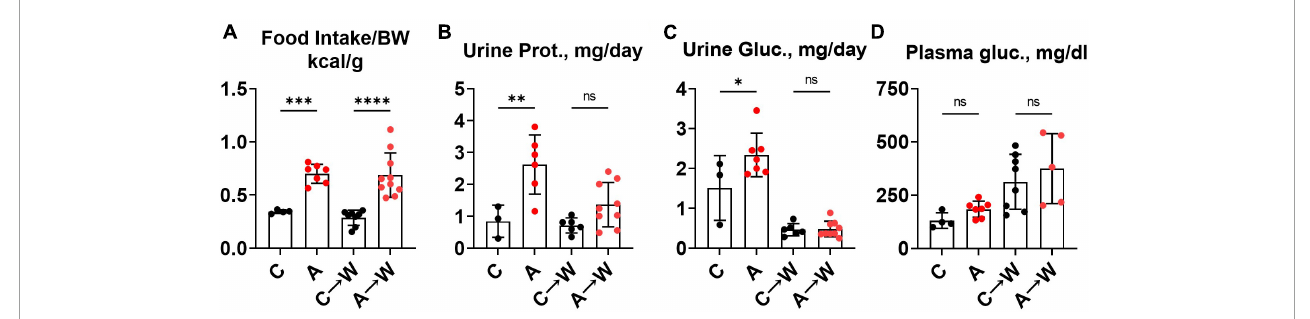
FIGURE8 Food intake, urinary macromolecule loss, and plasma glucose in WHC mice pre-treated with adenine before a western diet. (A) 24-h calorie intake from food (control diet—LabDiets 5001; western—Envigo TD.88137). (B) 24-h urine protein excretion. (C) 24-h urine glucose excretion. (D) Fasted plasma glucose. n = 4–10 per group; two-way ANOVA; ns, not significant; ∗ p < 0.05; ∗∗ p < 0.01; ∗∗∗ p < 0.001; ∗∗∗∗ p < 0.0001.